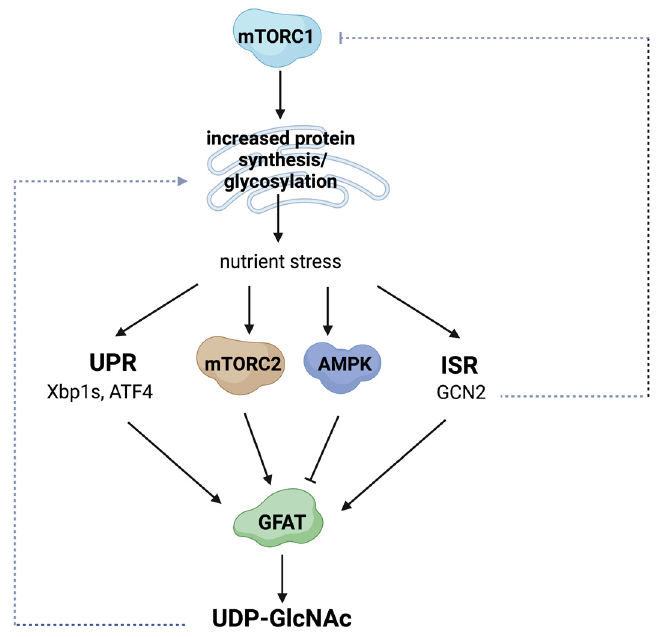
Figure 4. Conditions that increase demand for UDP-GlcNAc upregulate de novo HBP to maintain protein homeostasis.